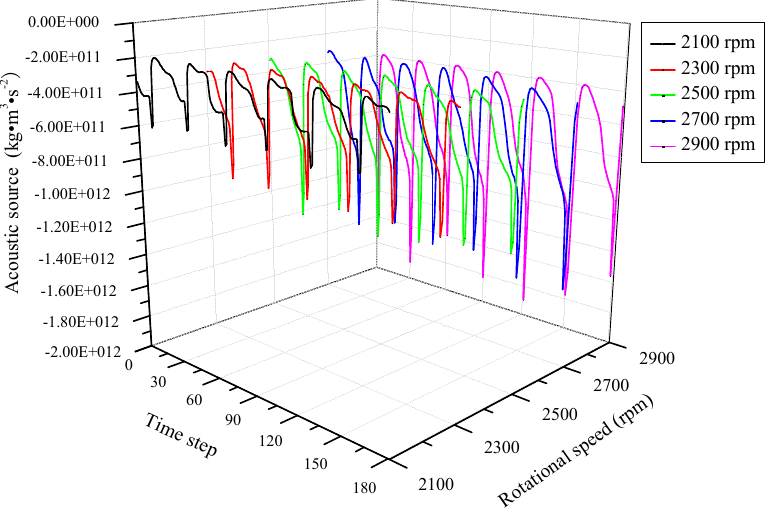
Figure 13. The fluctuation characteristics of acoustic source under various rotational speeds.